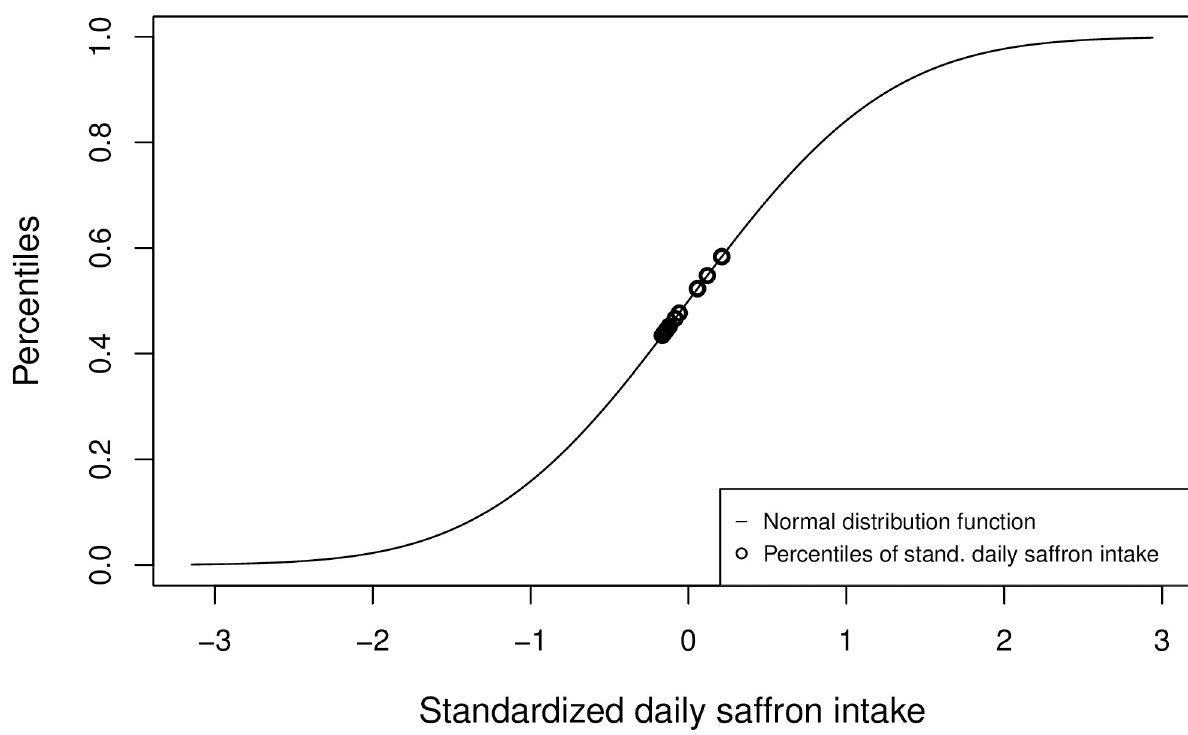
Fig 2. Daily saffron consumption Z-scores and their corresponding percentiles after transformation using the standard normal distribution function. The standardized daily saffron consumption of the subjects (Z-scores of simulated data, n = 13) are scaled into percentiles [0.434, 0.584] when using the method by Shivappa et al. [17]. By using the values � I � = 0.37, sd Saffron = 1.78 calculated by Shivappa et al. for the standardization, Saffron the percentiles cluster in the middle of the standard normal distribution function and do not fill the entire unit interval.